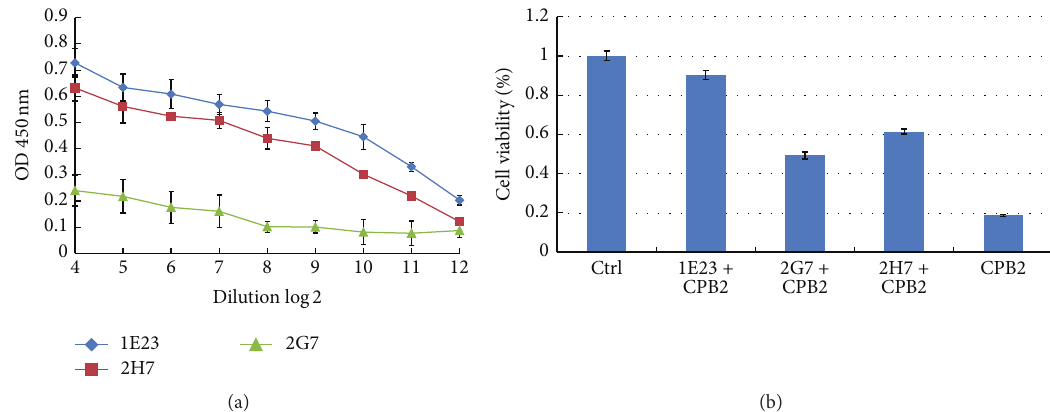
Figure 6: Characterizations of McAbs to CPB2 by an ELISA and abilities to neutralize rCPB2-induced cytotoxicity in vitro . (a) Titration of ascites of McAbs to CPB2 determined by an ELISA. An ELISA plate was coated with rCPB2 at concentration of 3.0 𝜇 g/mL; ascites of McAbs were diluted by 2-fold series dilution and incubated with above coated antigens; a reaction of antigen-antibody was detected by an ELISA. The result indicated that McAbs 1E23, 2G7, and 2H7 could be used for detecting CPB by an ELISA. (b) A capacity of McAbs to neutralize the toxicity of rCPB2 toxin in vitro . A 2x LD50 (30 𝜇 g/mL) of rCPB2 toxin was mixed with 200 𝜇 L of 50x diluted McAbs and incubated at 37 ∘ C for 2 h; the mixture was then applied to NCM460 cells incubated at 37 ∘ C for additional 12h. The cell viability was measured by an MTT assay. The result showed abilities of tested McAbs to neutralize the cytotoxicity of rCPB2 in vitro . Among these McAbs, 1E23 displayed the most potential to neutralize the cytotoxicity of rCPB at a dose of 30 𝜇 g/mL.